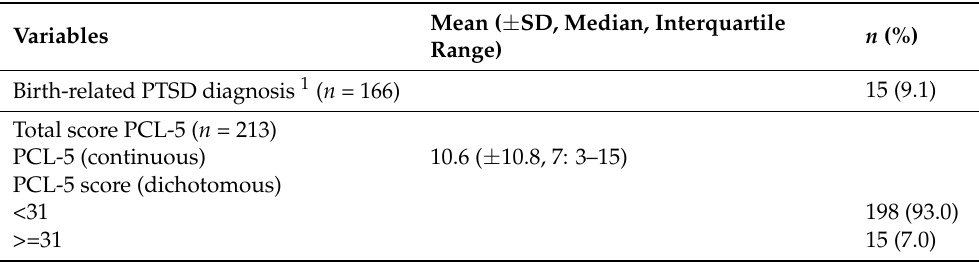
Table 8. Birth-related PTSD at one month post-partum.